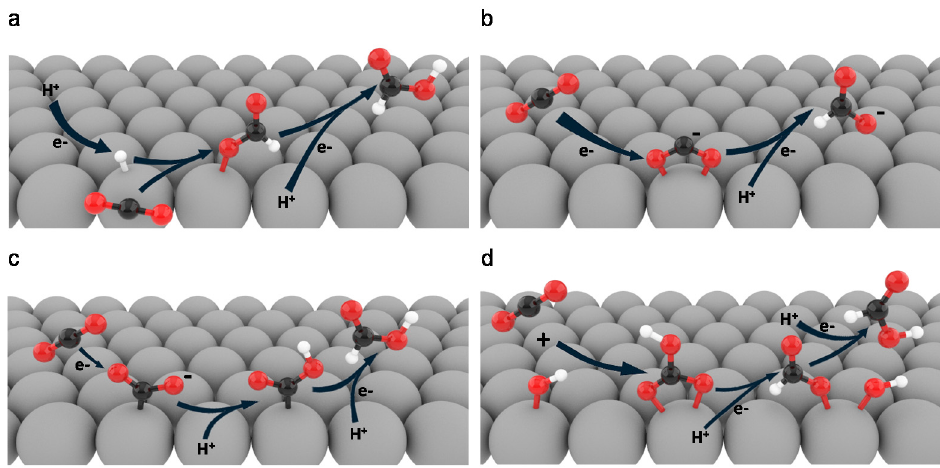
Figure 1. Reaction pathways for HCOOH (HCOO − ) production. ( a ) CO 2 insertion into a metal-H bond [36]; ( b ) CO 2 to HCOO − via O-bound intermediate [36]; ( c ) CO 2 to HCOOH via C-bound intermediate [51,52]; and ( d ) HCOOH production from CO 3 H* [47]. Color codes: black, C; red, O; white, H; grey, metals.